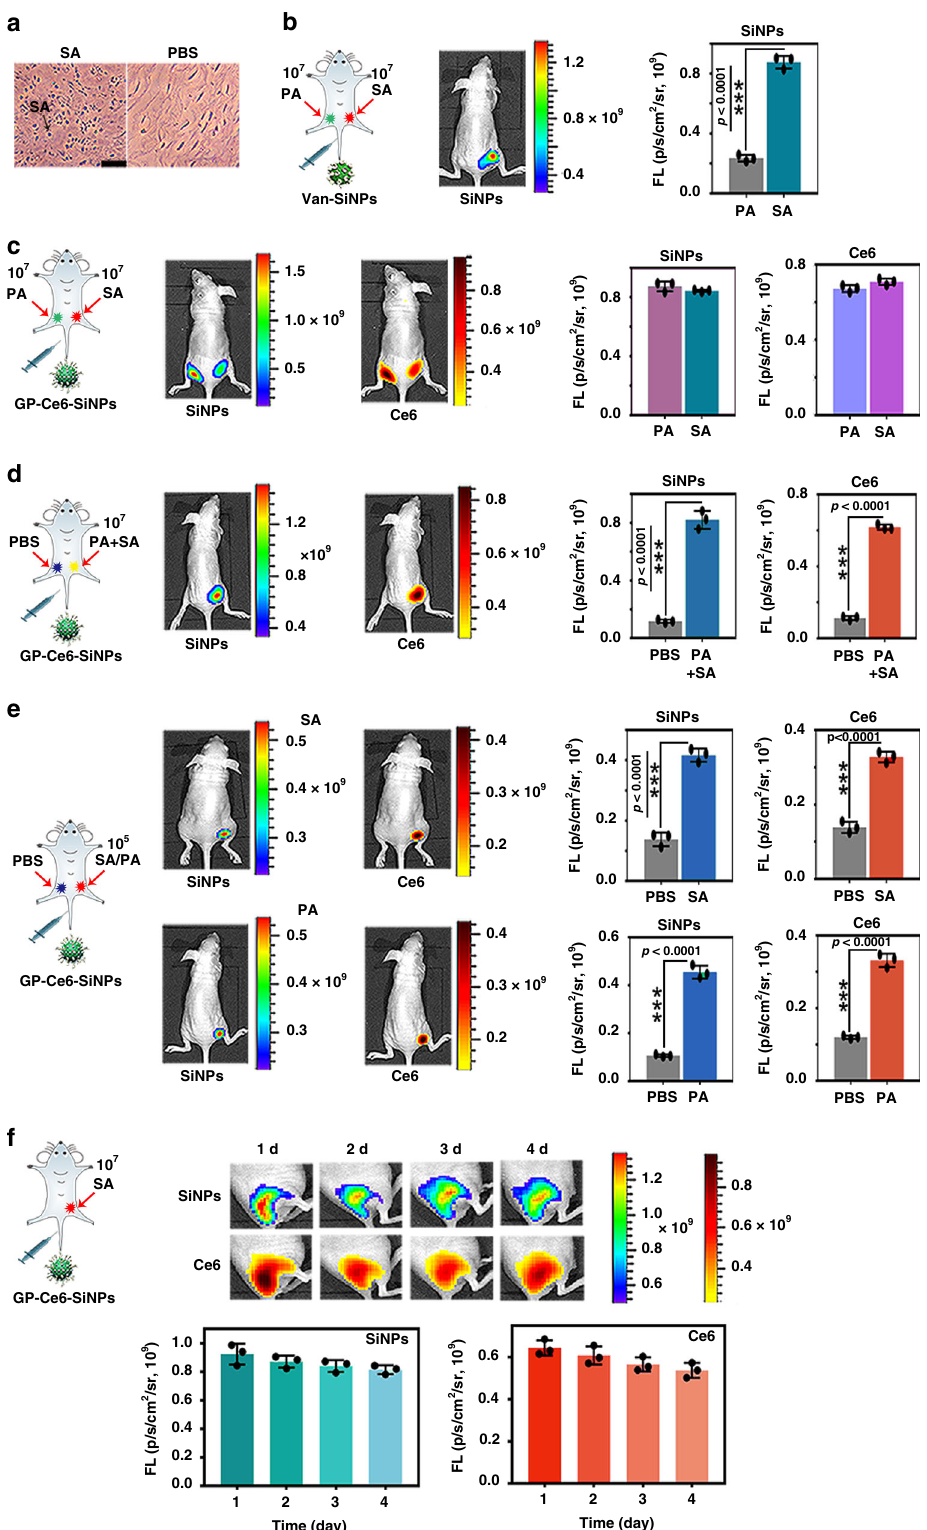
In vivo antibacterial activity of GP-Ce6-SiNPs . To further evaluate the antibacterial ability of GP-Ce6-SiNPs in vivo, 50 μ L of SA (1.0 × 10 7 CFU) and PA (1.0 × 10 7 CFU) are injected into the right thigh of the mice, respectively. Then these two groups of bacteria (SA, PA)-infected mice are intravenously injected with 100 μ L of PBS and GP-Ce6-SiNPs under 660-nm